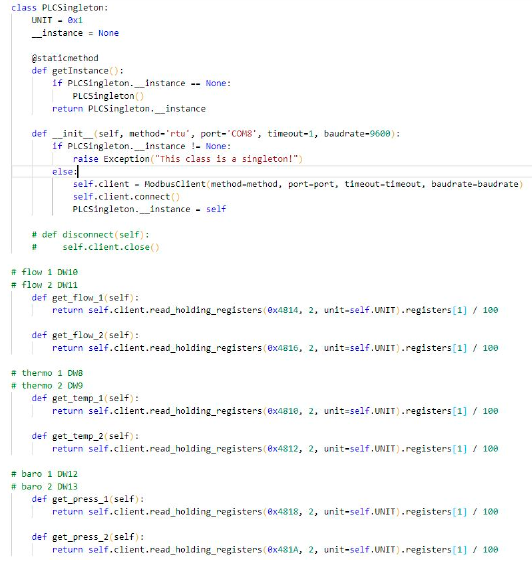
Figure 8. Functions that read the state of the PLC registers.